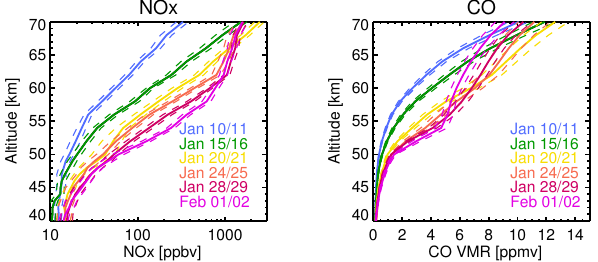
Figure 5. Two-daily average altitude profiles of NO x (left) and Fig. 5. Two-daily average altitude profiles of NOx (left) and CO (right) on six 2-day periods from January 10, 2004, to February 02, 2004, insidethepolarvortex(equivalentlatitudespolewardof65 ◦ ). Dashedlinesdenotetheerrorofthemean. CO (right) on six 2-day periods from 10 January 2004 to 2 Febru- ary 2004, inside the polar vortex (equivalent latitudes poleward of 65 ◦ ). Dashed lines denote the error of the mean.